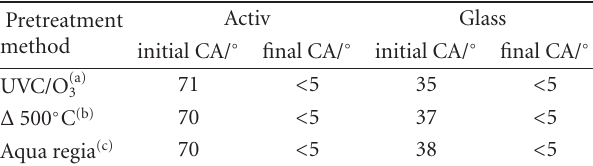
Table 1: Table of water contact angles for Activ and glass samples before and after pretreatment.